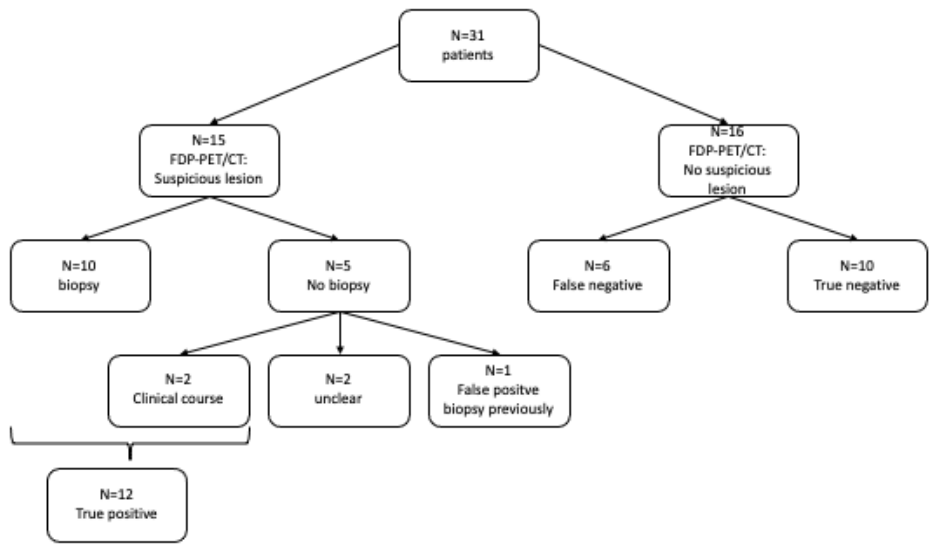
Figure 2. Primary tumor.